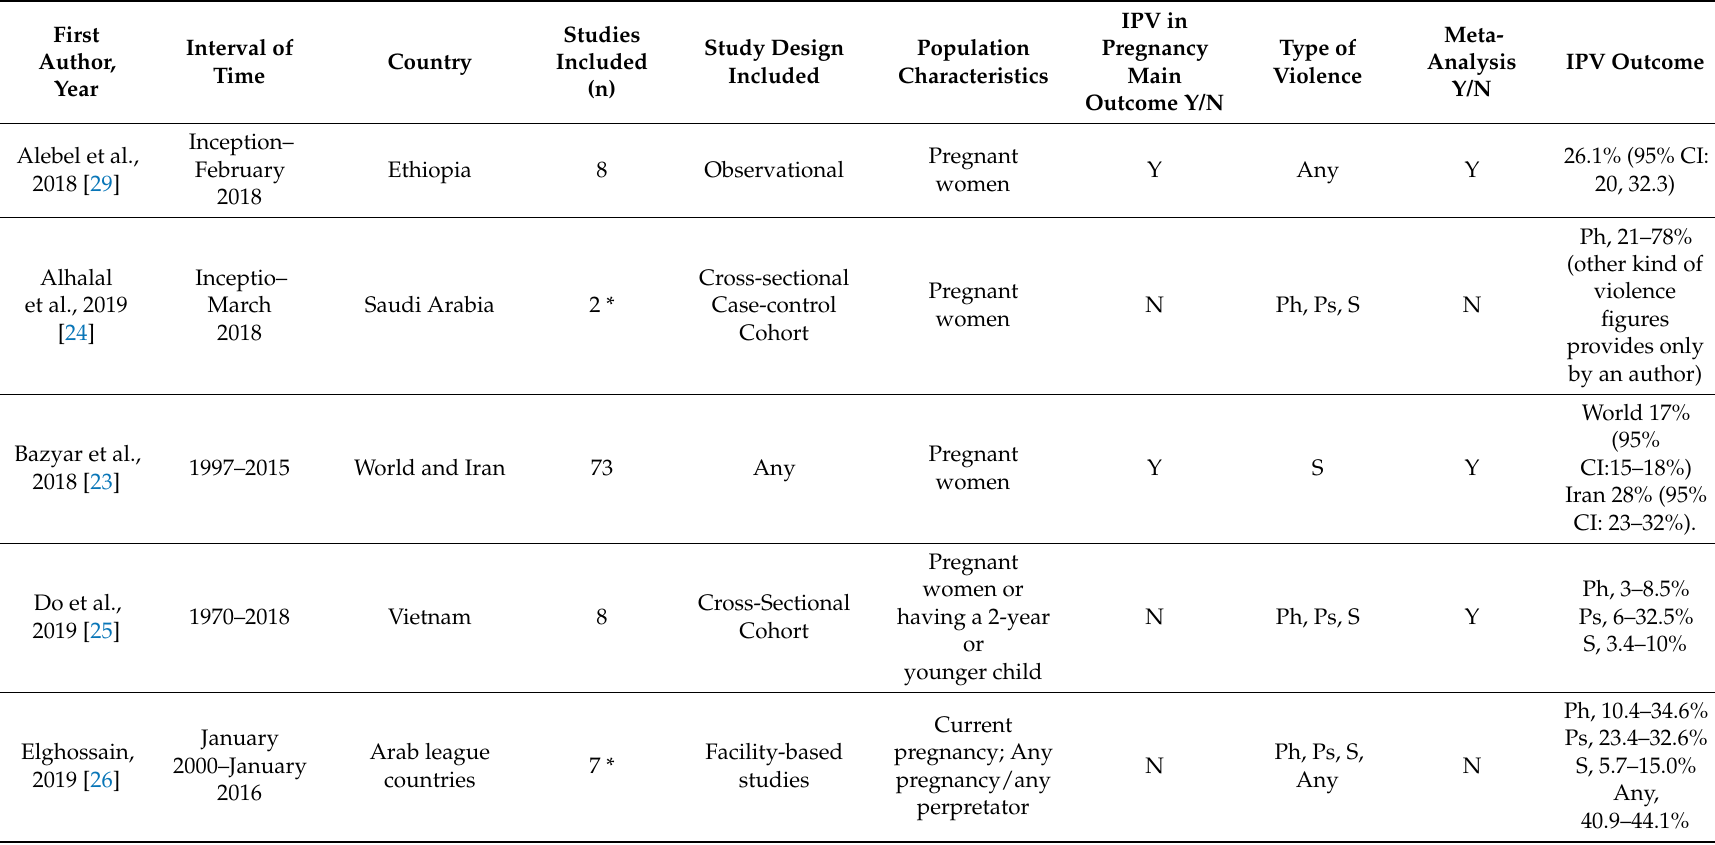
Table 2. Characteristics of the studies selected for the umbrella review of reviews of worldwide prevalence of IPV in